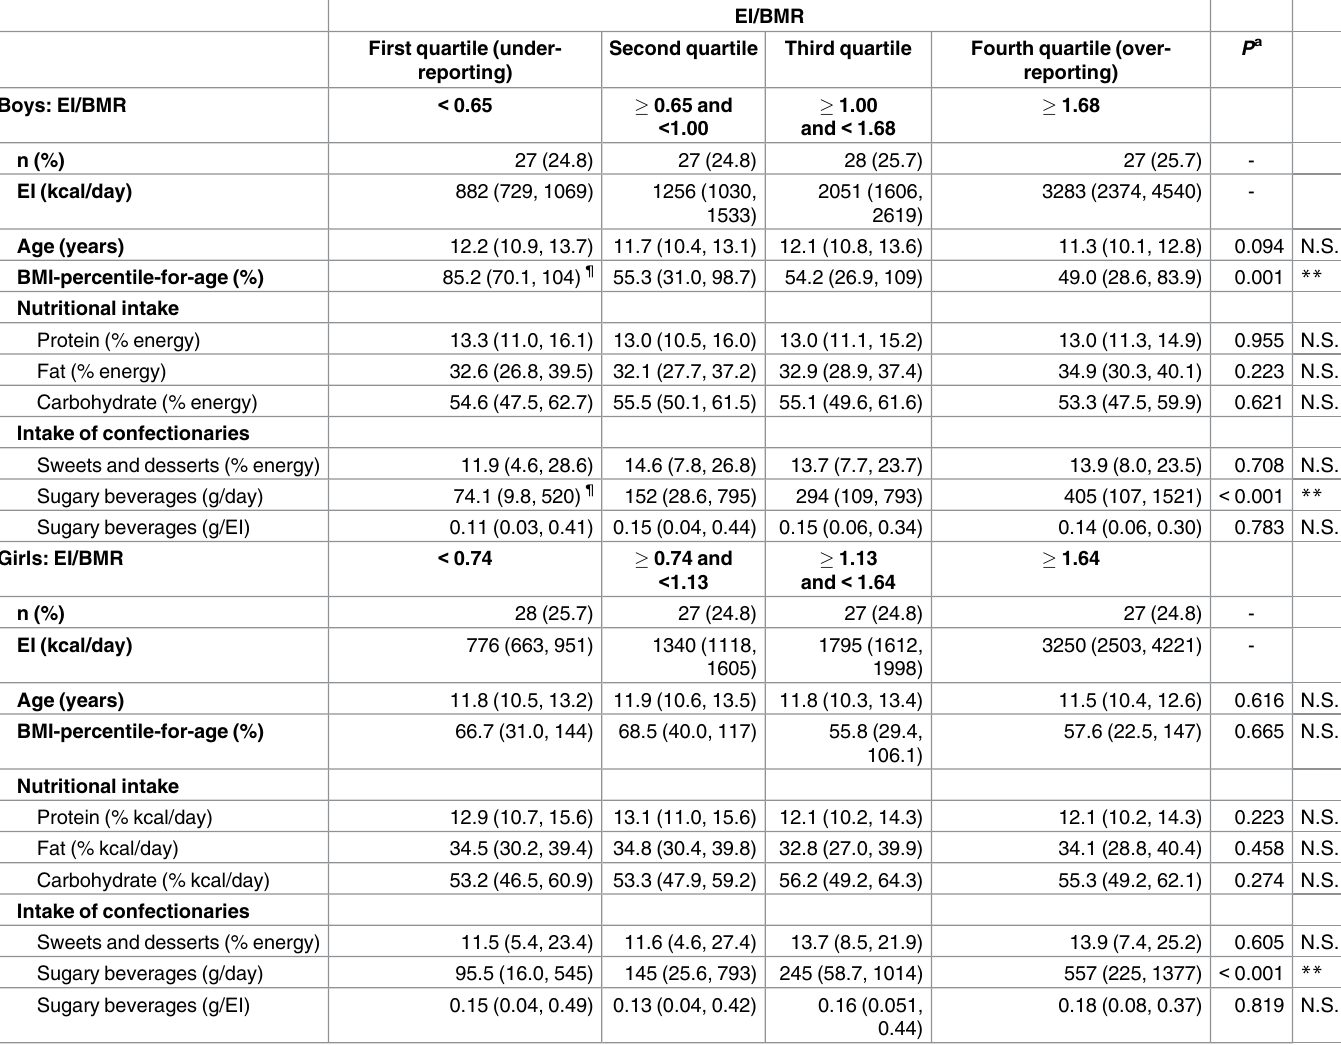
Table 2. The Differences in Age, BMI-Percentile-For-Age and Dietary Intake Acrossthe Quartiles of EI/BMR.